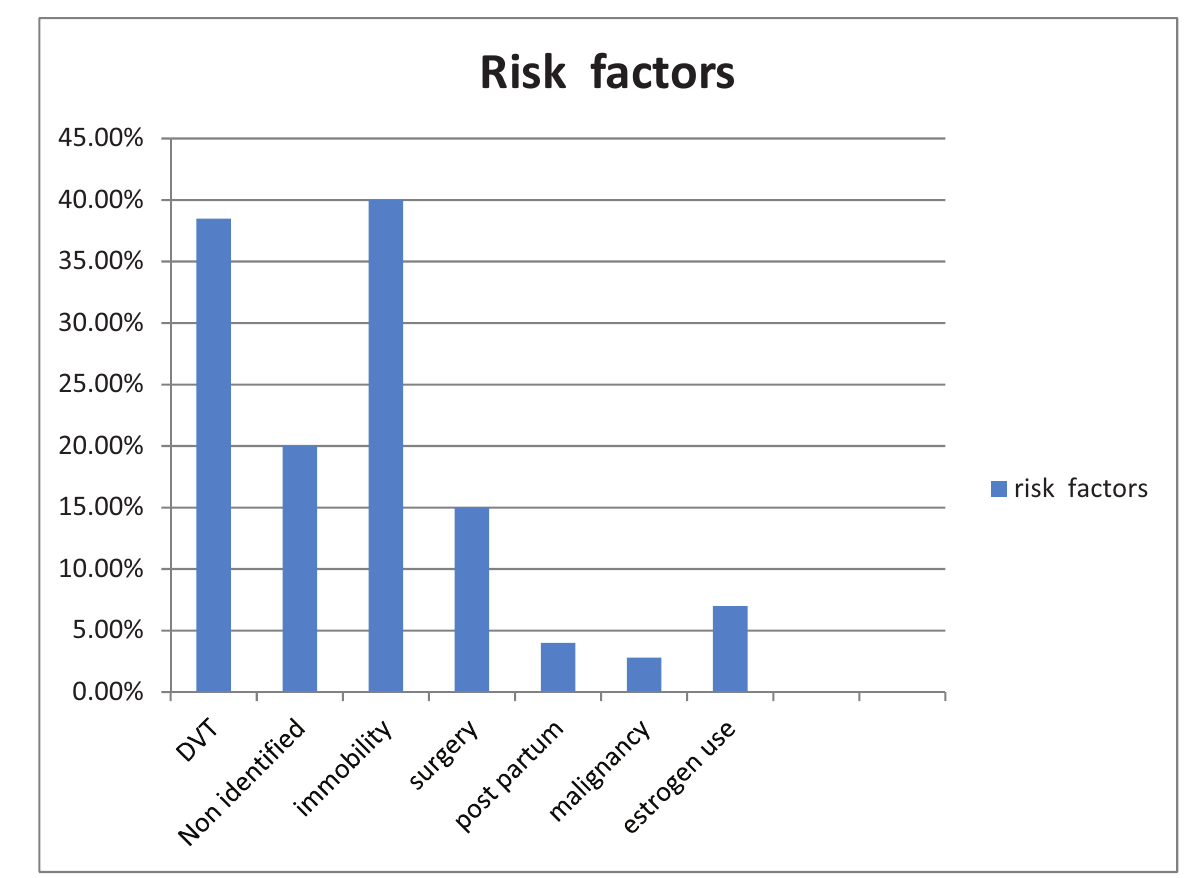
Illustrates risk factors of pulmonary embolism within study